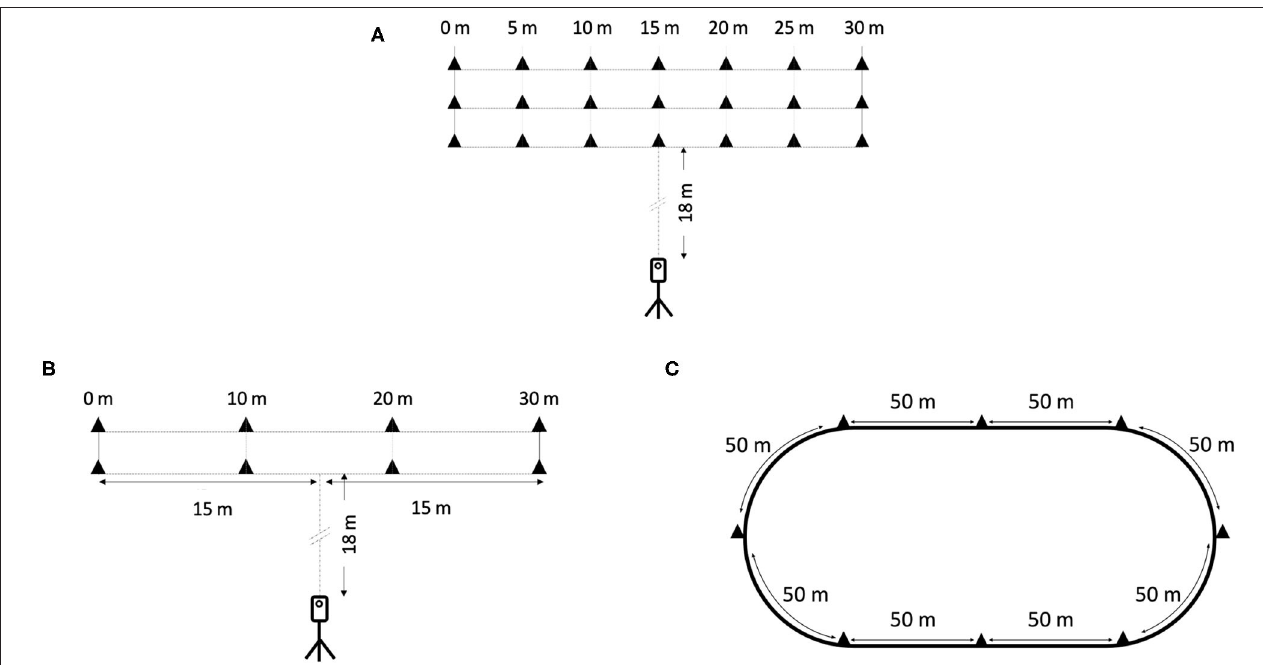
FIGURE 1 | Representation of testing protocol (PRE and POST). (A) Repeated sprint ability test, (B) maximal sprint speed test, and (C) maximal aerobic speed test.